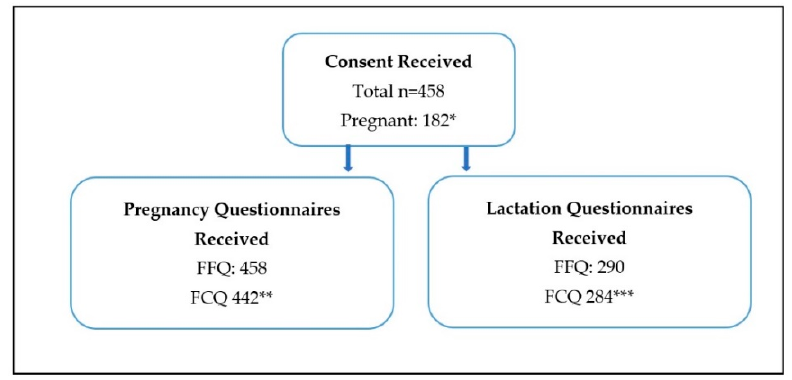
Figure 1. Questionnaires completed. * of women who were pregnant, 14 gave birth and accepted an invitation to complete the lactation questionnaires within recruitment time. ** The pregnancy FCQ was not completed by 16 women. *** The lactation FCQ was not completed by 6 women. Table 1. Participant characteristics.